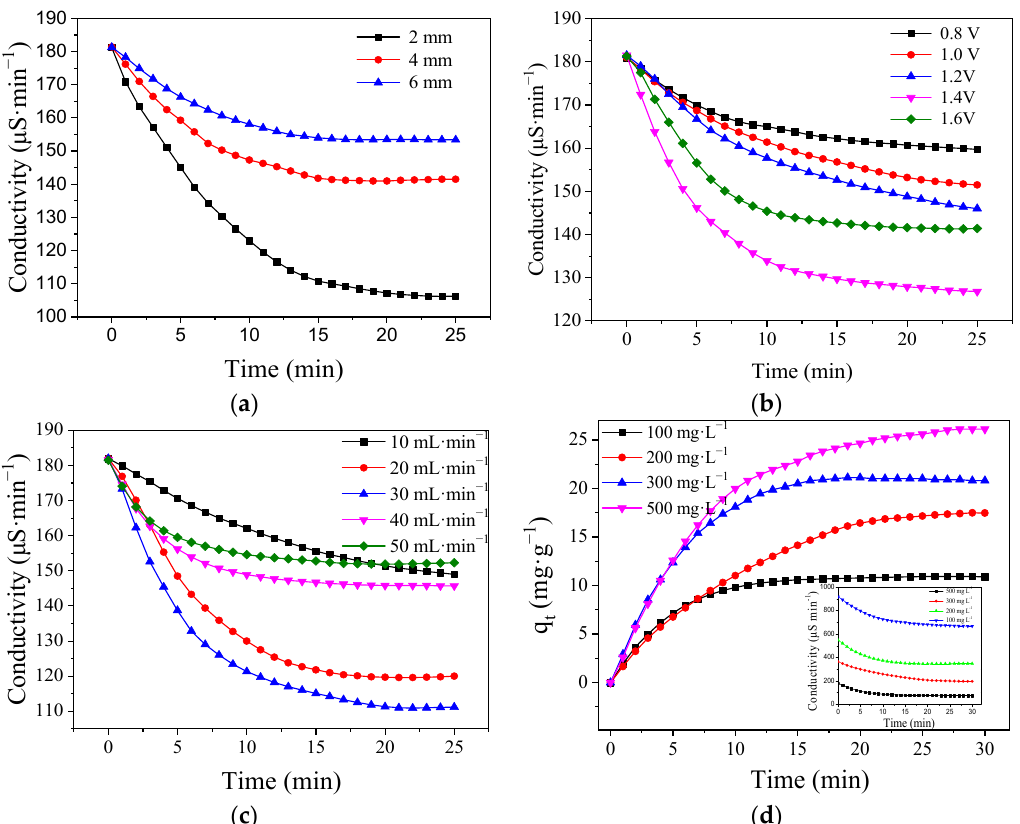
Figure 3. Effects of electrode spacing ( a ), applied voltage ( b ), volume flow rate ( c ), and NaCl concentration ( d ) on desalination performance.